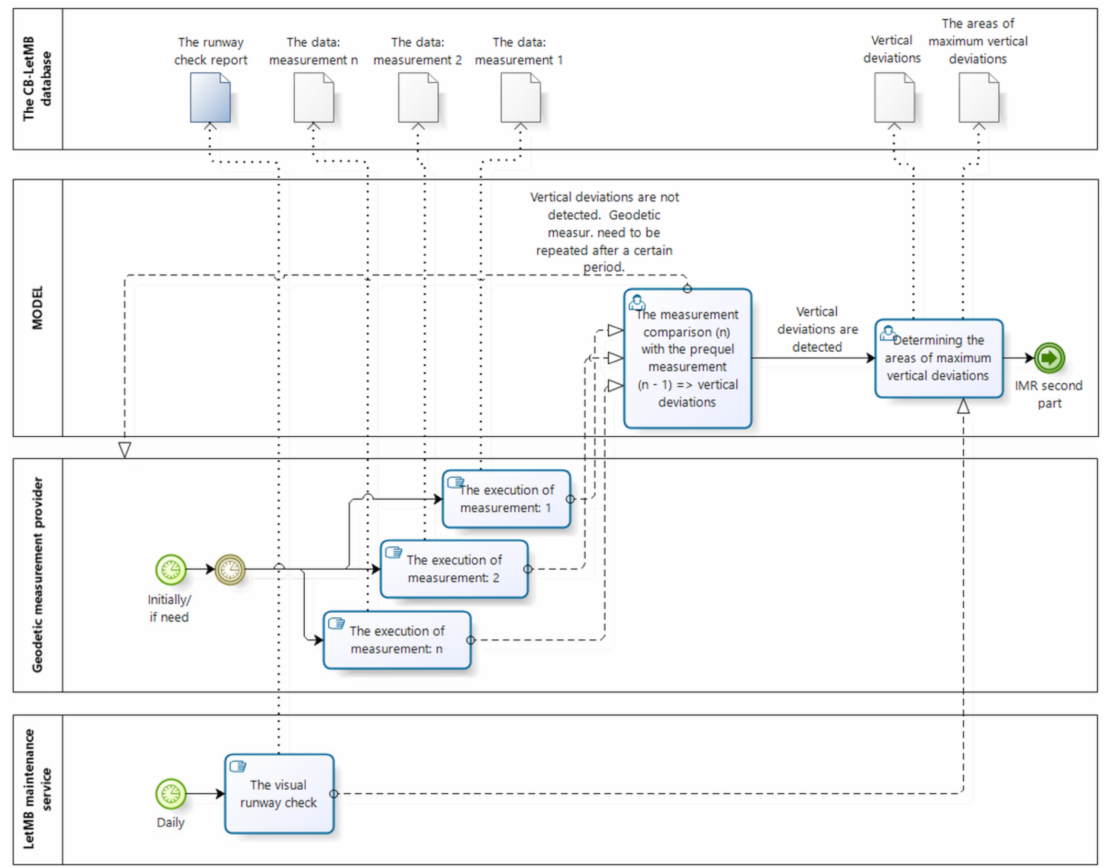
Figure 6. First part of the BPD’s process decision-making maintenance model